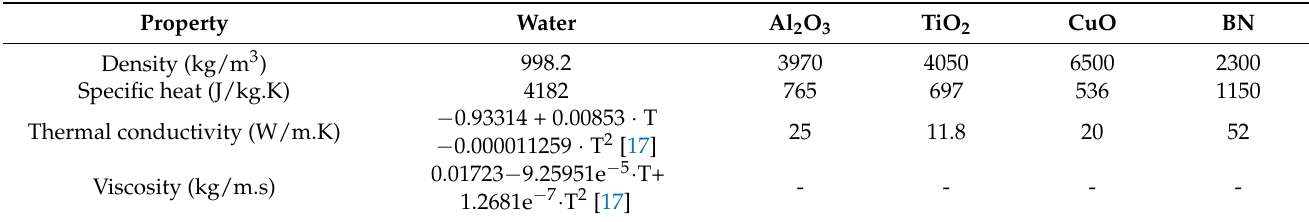
Table 1. Thermophysical properties of Nanoparticles and Pure Water at 303.15